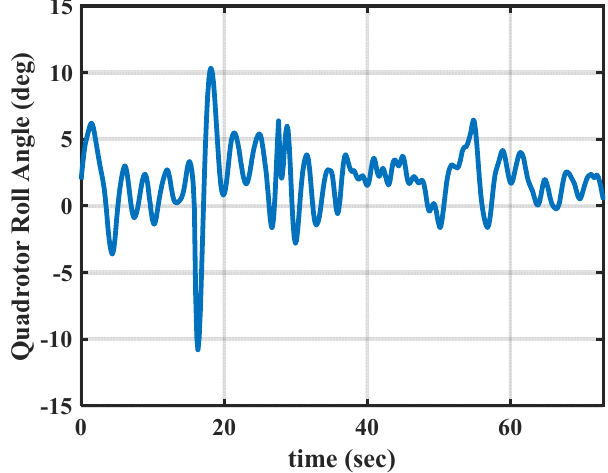
Figure 15. Quadcopter roll angle.